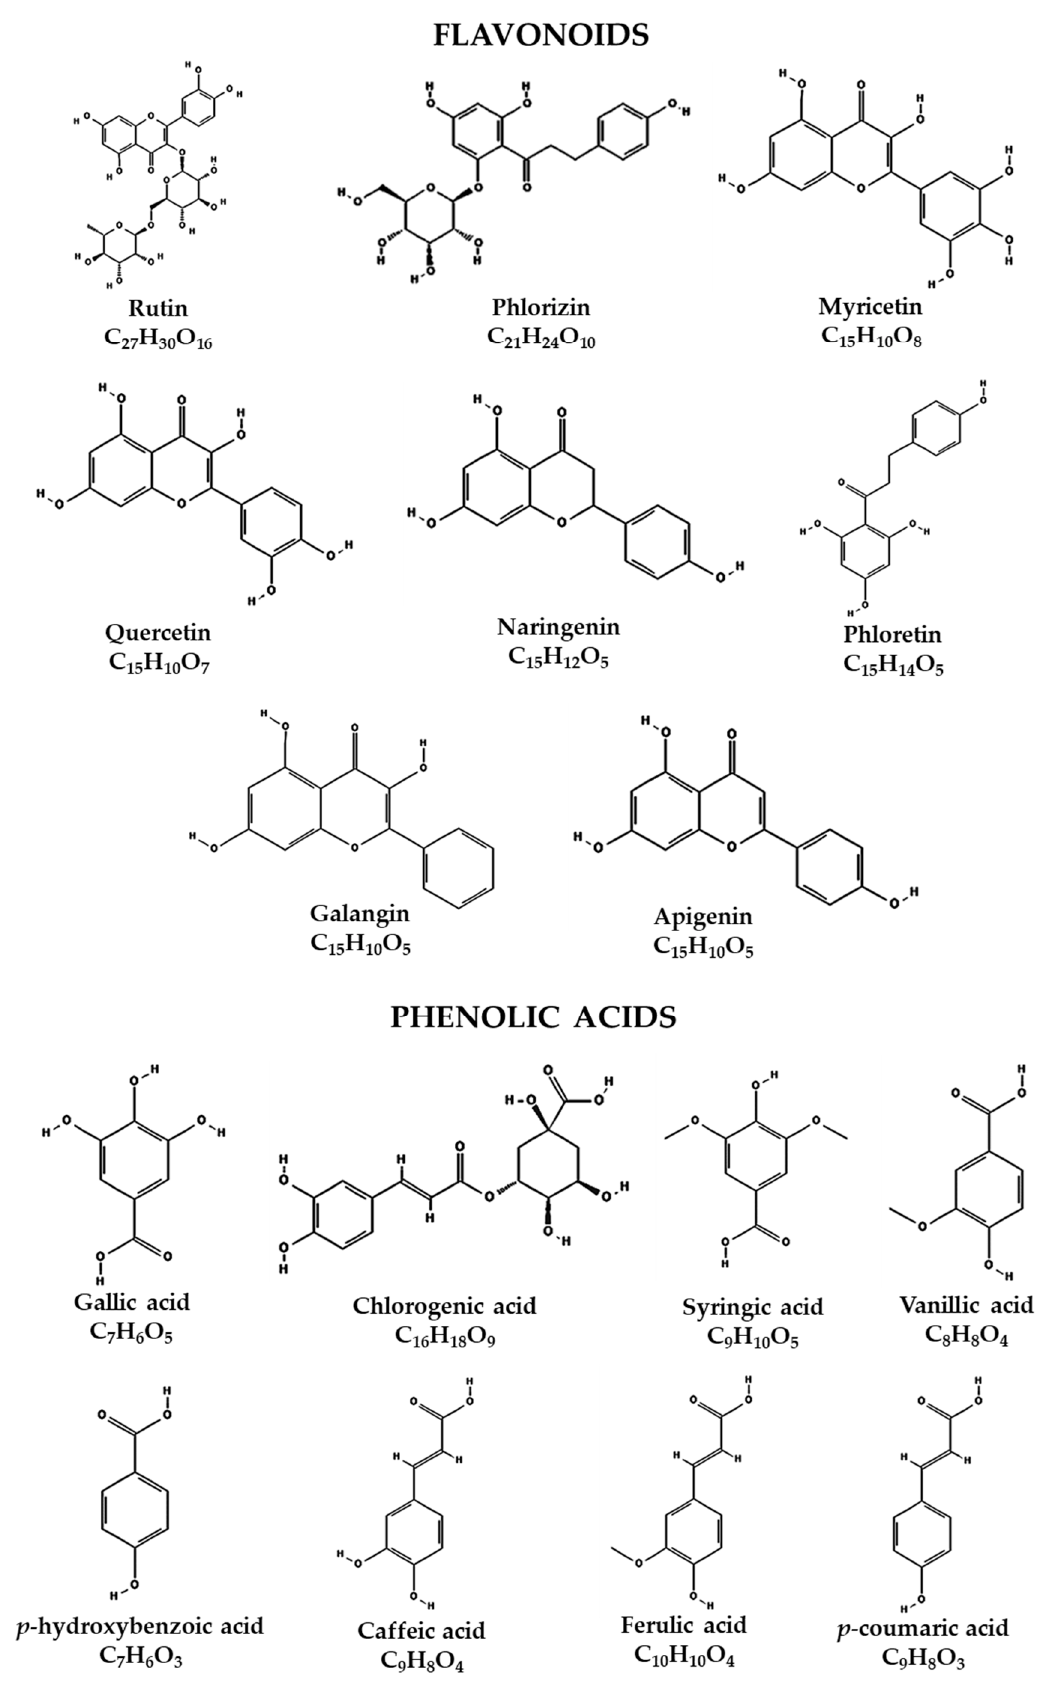
Figure 2. Chemical structure of flavonoids and phenolic acids identified in the extract of fruits of hybrid H387 07.